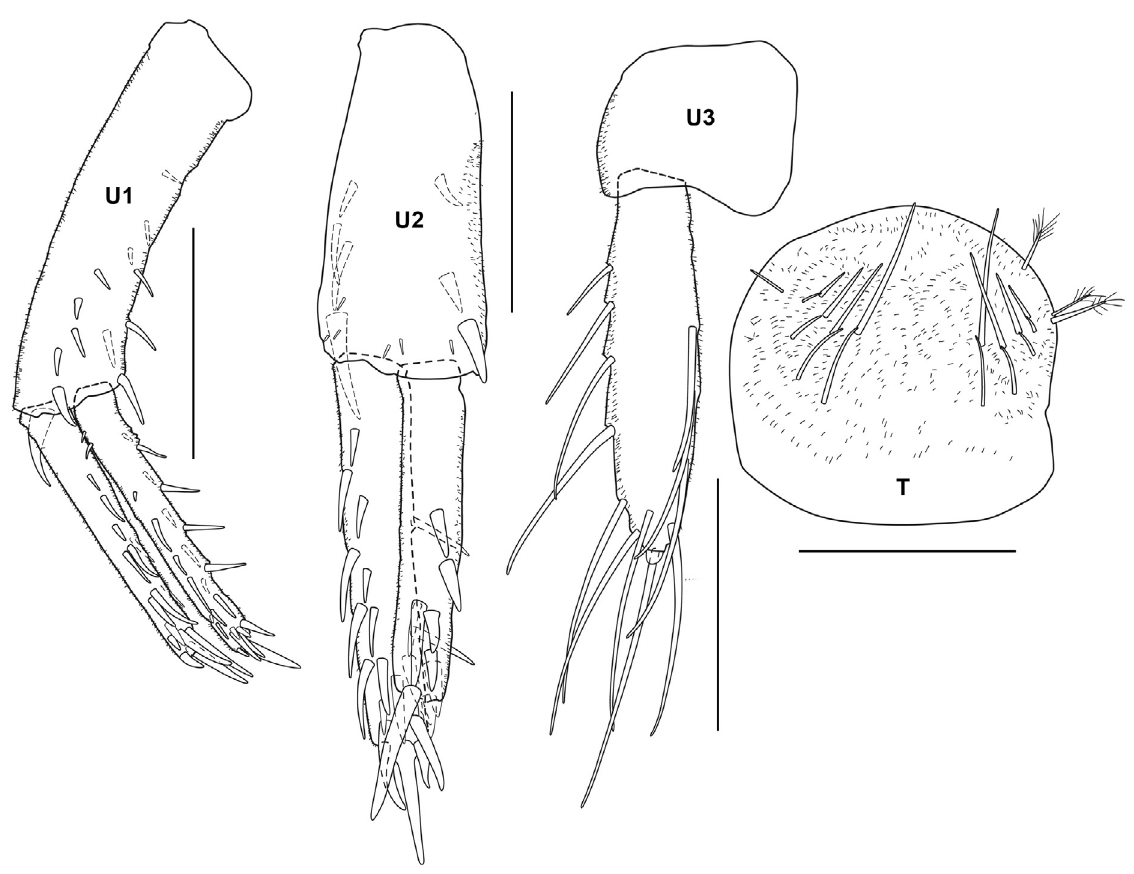
Fig. 19. Grandidierella sungeicina sp. nov., allotype, ♀ (ZRC 2018.0491). Scale bars: 0.25